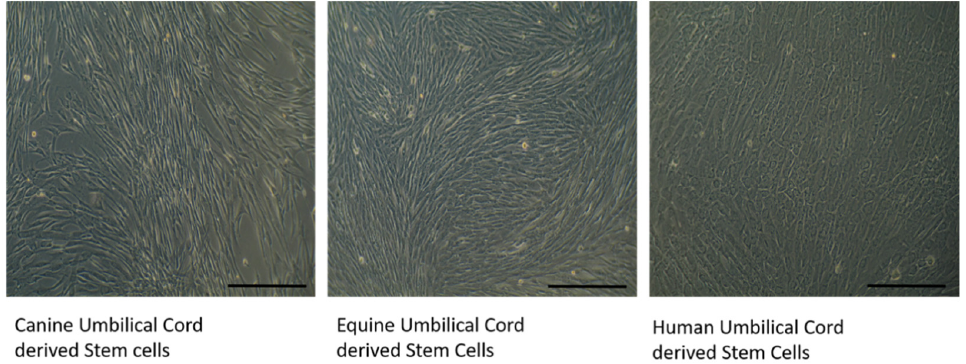
Figure 3. Umbilical cord mesenchymal stem cells (MSCs) from three different species (Magnification 10× − Scale bar = 400 μ m): canine (P4), equine (P4) and human (P3).